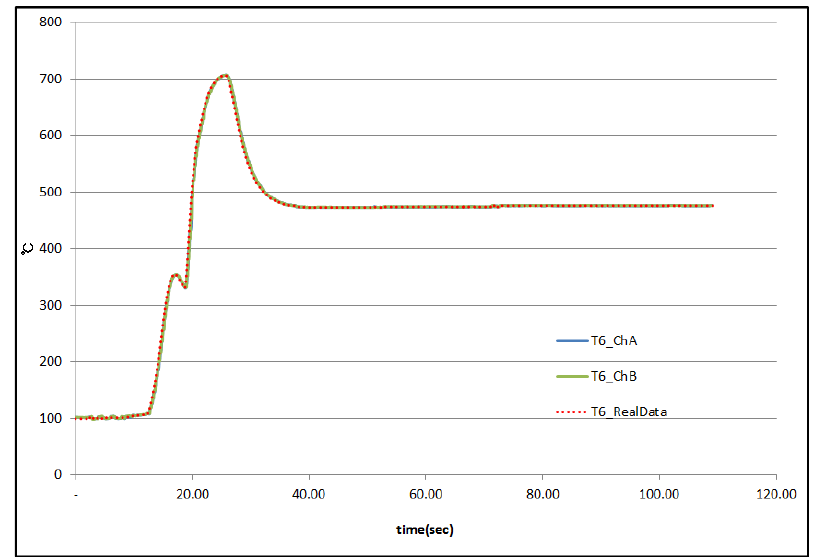
Figure 11. Result of startup phase performance test (T6).